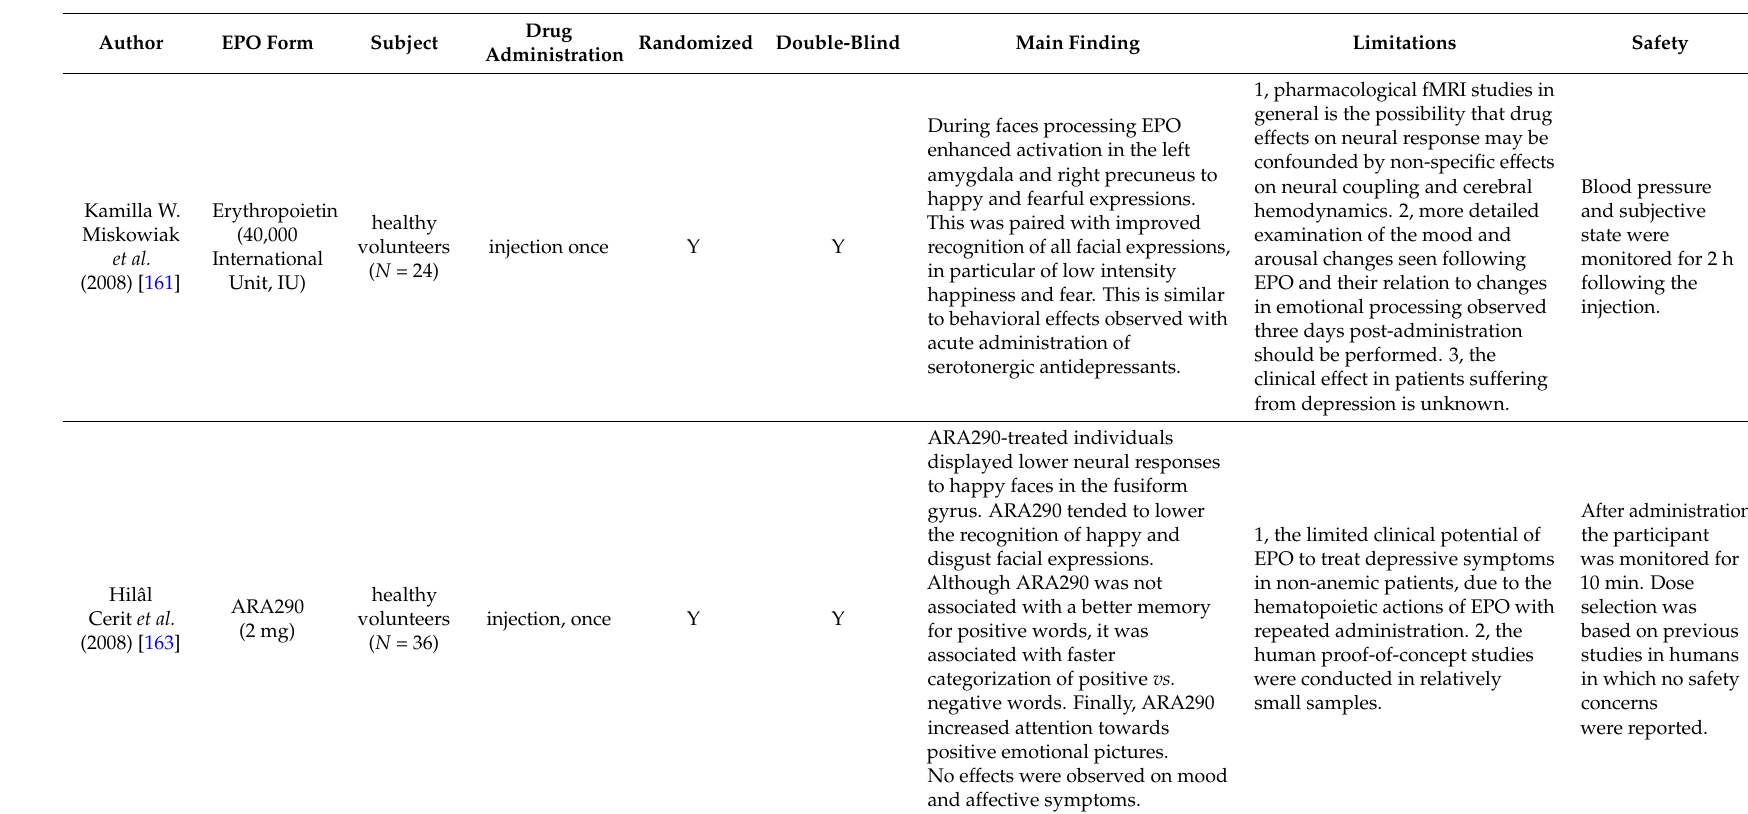
Table 1. Clinical study on the antidepressant effect of